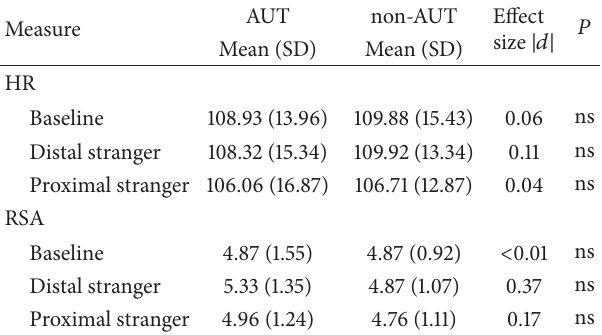
Table 2: Descriptive data for heart rate (HR) and respiratory sinus arrhythmia (RSA) measures for the autistic (AUT) and nonautistic (non-AUT)